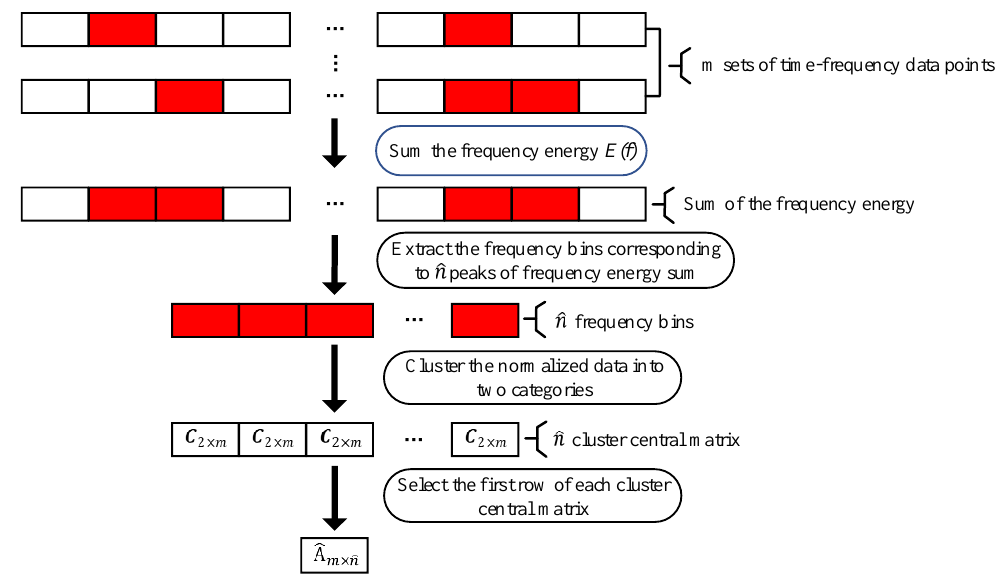
Figure 2. The schematic diagram of mixing matrix estimation.